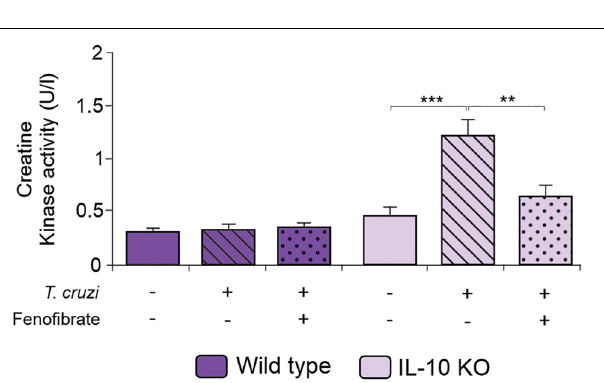
FIGURE 5 | Serum Creatinine Kinase. CK activity was measured in the serum of uninfected, T. cruzi- infected, and T. cruzi- infected fenofibrate-treated WT and IL-10 KO mice using a colorimetric assay. Differences between groups were analyzed by Student t test and ANOVA followed by Tukey post hoc test. Differences between groups were analyzed ANOVA (mean ± SEM) followed by Tukey post hoc test. Differences were considered significant when p < 0.05. 7 mice per group, 3 replicate experiments. ** p < 0.01 and *** p <